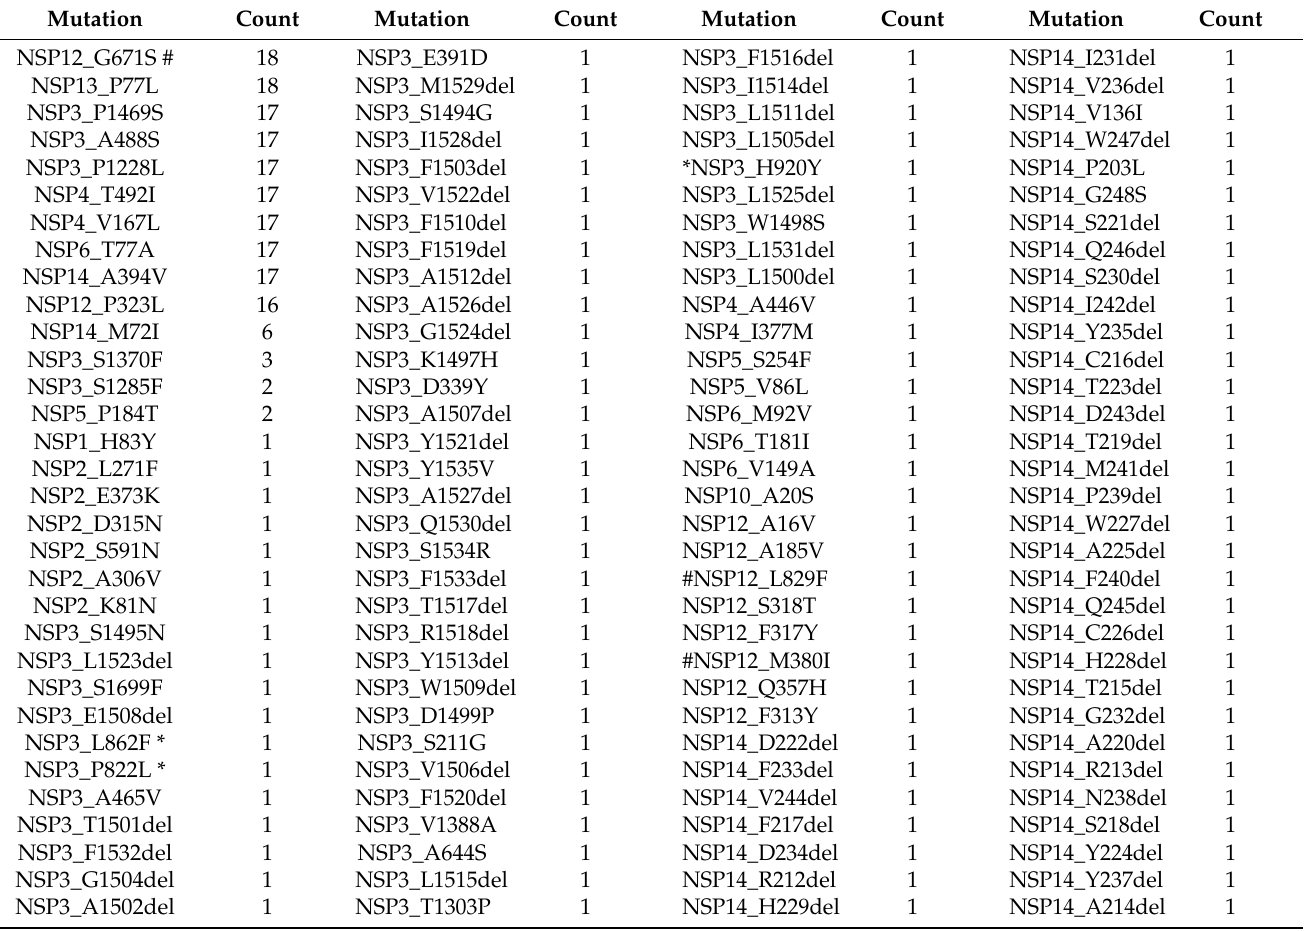
Table 5. Mutations in NSP of SARS-CoV-2 circulating isolates in Punjab